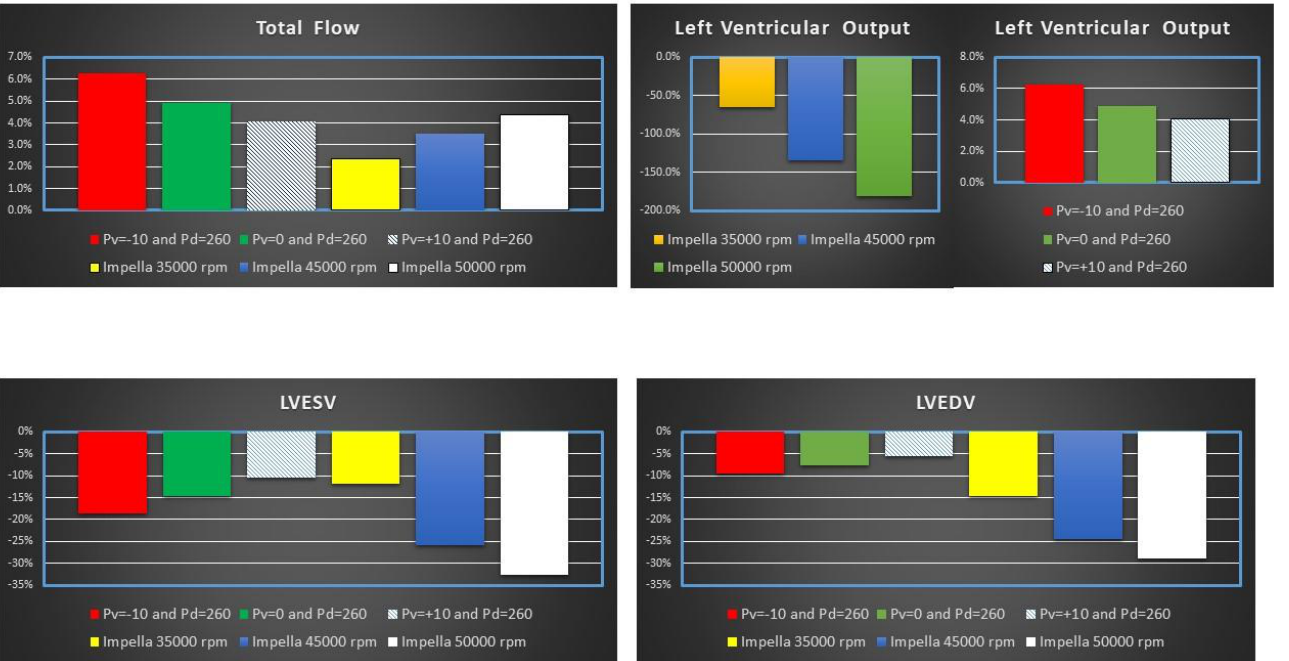
Figure 5. Percentage change calculated in comparison to baseline conditions for total flow, left ventricular output (LVO), LVEDV and LVESV when IABP or Impella 2.5 (LVAD) support were simulated. The simulation settings included LVAD rotational speed at 35,000, 45,000 and 50,000 rpm and IABP support with Pv = − 10, Pv = 0 and Pv = +10 mmHg, and Pd = 260 mmHg. LVO (or CO) is the Total Flow under IABP support. The sum of CO and LVAD flow gives the total flow under Impella 2.5 support.